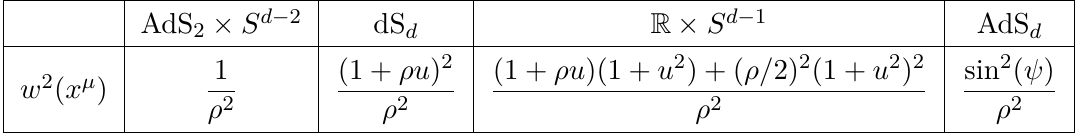
Table 2 . Different choices for the conformal factor w 2 ( x µ ) in (2.4) that result in a variety of interesting space-times.